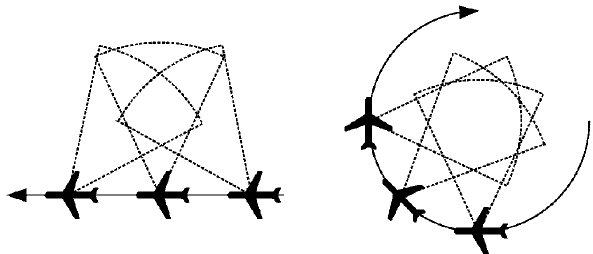
Figure 4. Flight patterns of GLORIA onboard HALO or M55- Geophysica. The panning range of the instrument is illustrated by dashed lines. Line-of-sight (LOS) panning allows for tomographic measurements even during linear flights (left), since a fraction of the air volume covered is observed from different directions. The tomo- graphic capabilities can be further enhanced by choosing a closed flight pattern like a circle